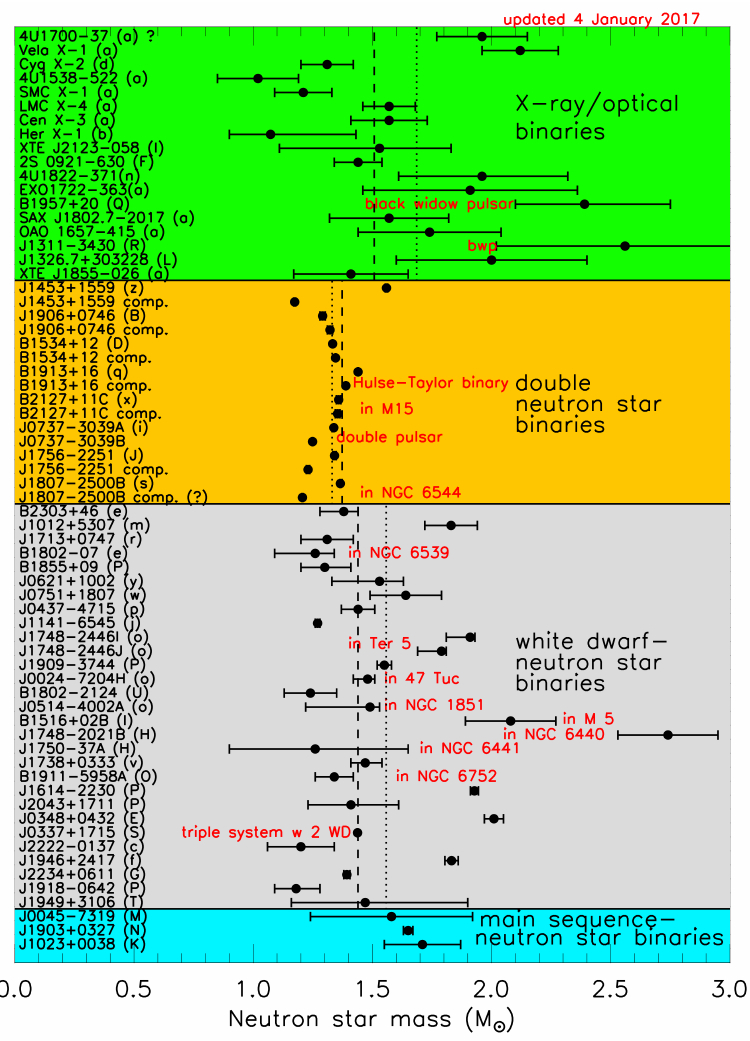
Figure 2. Masses measured from pulsar timing. Vertical dashed (dotted) lines indicate category error-weighted (unweighted) averages. The figure is updated from that of Ref.